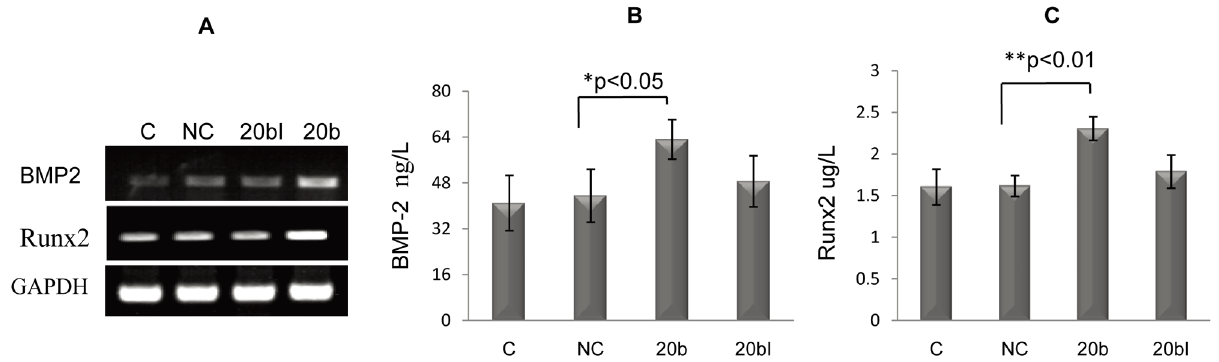
Figure 2. miR-20b activates BMP/Runx2 signaling pathway. (A) miR-20b mimic-transfected MSCs were collected at day 6. RT-PCR results showed an up-regulation on the mRNA expression of BMP2 and Runx2 by miR-20b at day 6 in hMSCs respectively. (B) and (C) are the results of ELISA analysis on the expression of BMP-2 and Runx2 on day 6 during osteogenesis after miR-20b transfection (n=4, *p , 0.05, **p , 0.01.) C: control; NC: negative control (small RNA with random sequence); 20bI: miR-20b inhibitor.